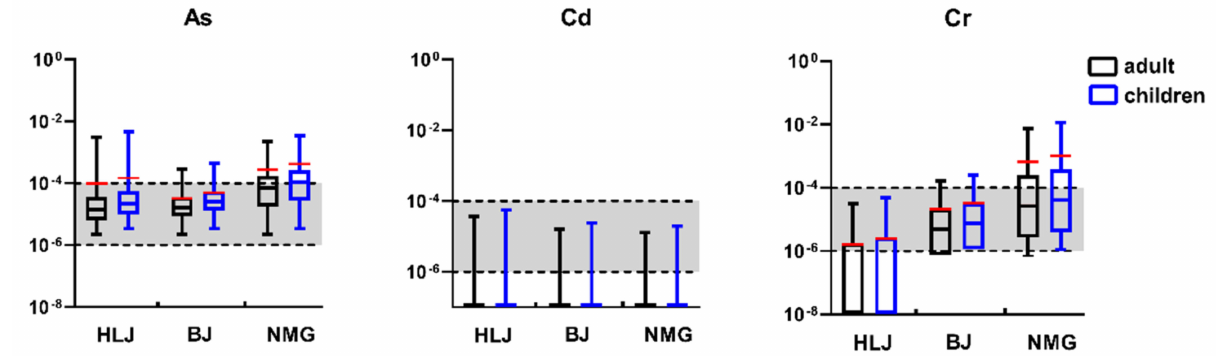
Figure 4. Carcinogenic risk of heavy metals by ingestion of wells water for adults and children. The red line is the average value. The black dotted line is carcinogenic risk values of 10 − 6 or 10 − 4